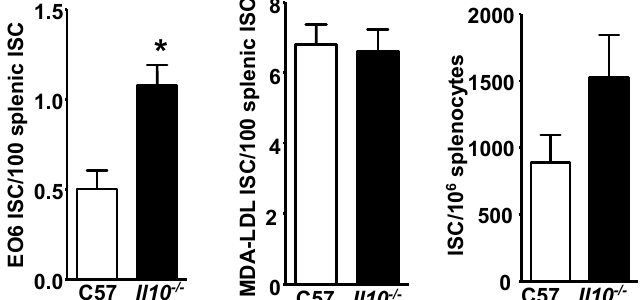
Figure 5. Increased levels of E06 ISC in the spleen of Il-10 − / − mice. E06 ISC, MDA-LDL ISC and total ISC in the spleen of 8-week old chow fed female C57BL / 6 and Il10 − / − mice were identified by ELISPOT assay. The results are the mean ± SEM of n = 13–15 pooled from three independent experiments. Significance: * p < 0.001.